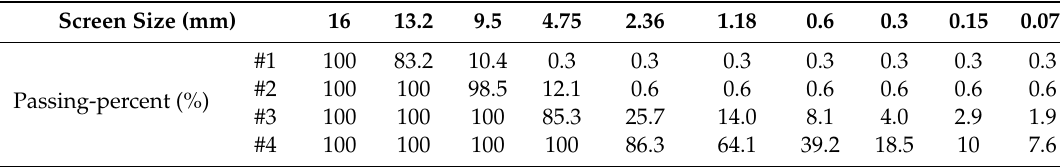
Table 7. Analysis results of different mineral aggregates.